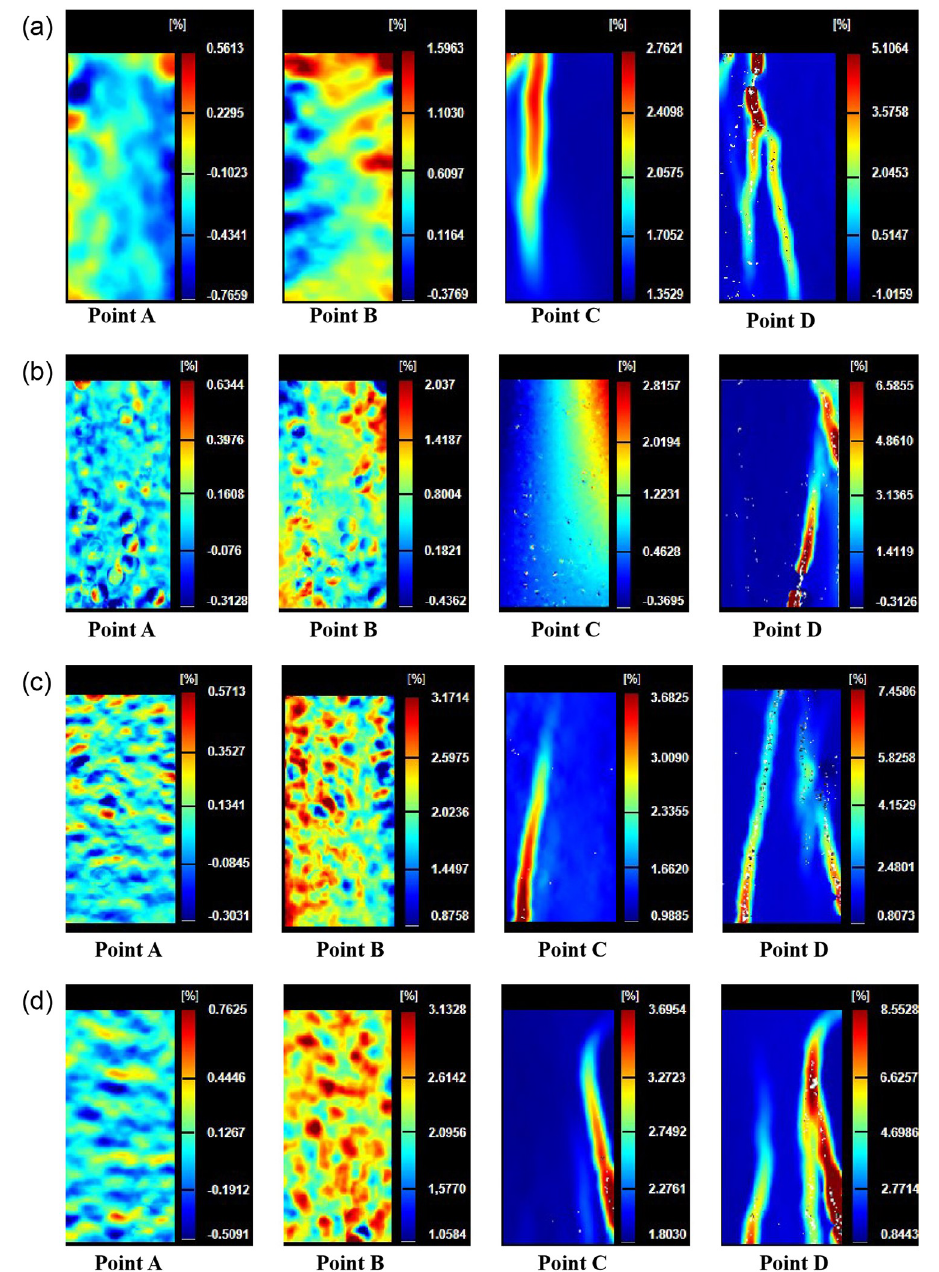
Fig 5. Local strain field evolution of sandstone with different freeze-thaw cycles. (a) N = 20 (b) N = 40 (c) N = 60 (d) N = 80 . reached the maximum degree of expansion and extension, and the surface of the specimen had developed derived cracks. The characteristics of the strain field at point B of the stress- strain curve of the specimen with different freeze-thaw cycles were different. As freeze-thaw cycles increased, the area of significant color region also increased. Moreover, the development modes of derived cracks of specimens with different freeze-thaw cycles were different. The derived cracks of the specimens with freeze-thaw cycles of 20 and 40 were new fine textures